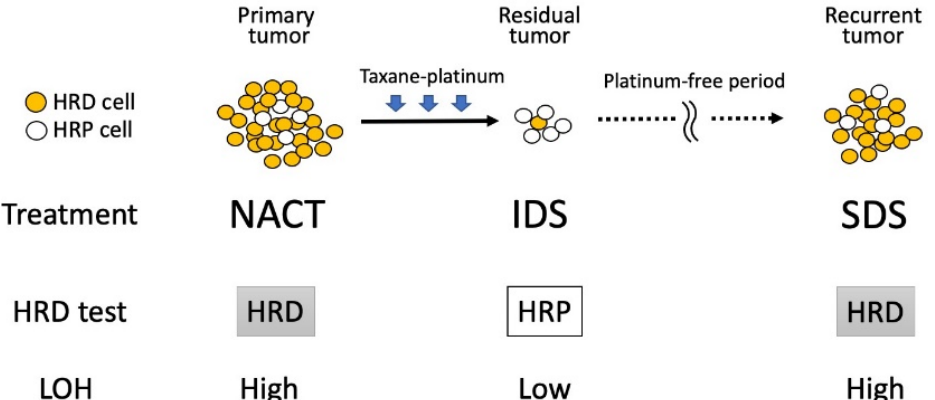
Figure 1. Changes in HRD status during the treatment of ovarian cancer. Even though primary tumors are predominantly composed of HRD-positive cells, they are likely to be eradicated by platinum-based chemotherapy, and residual tumors may be occupied by HRD-negative cells, representing the HRP phenotype. However, after a platinum-free period, remnant HRD-positive cells that have a growth advantage can form recurrent tumors, exhibiting the HRD phenotype. These acronyms are defined as follows: HRD, homologous recombination deficiency; HRP, homologous recombination proficiency; IDS, interval debulking surgery; LOH, loss of heterozygosity; NACT, neoadjuvant chemotherapy; SDS, secondary debulking surgery.